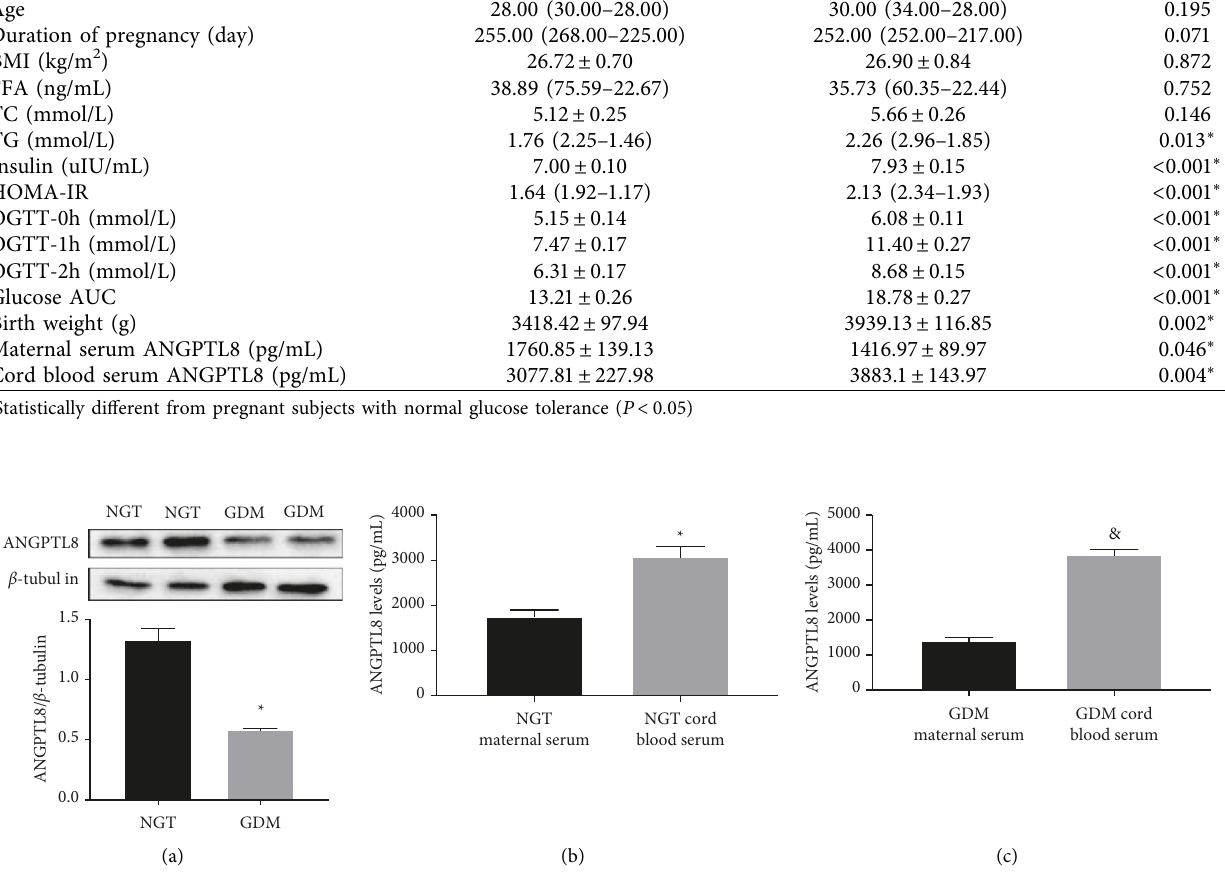
Table 1: Characteristics of pregnant subjects with normal glucose tolerance (NGT) and pregnant subjects with diabetes mellitus (GDM).